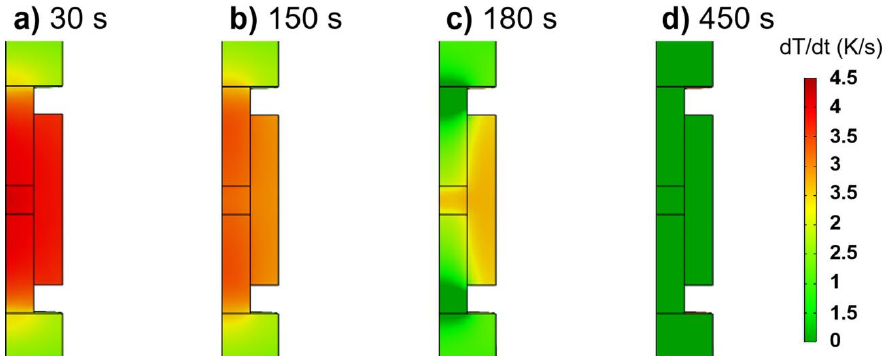
Figure 4. Typical heating rate fields from the punch-controlled PID regulation of regular temperature profile at different times: ( a ) 30 s; ( b ) 150 s; ( c ) 180 s; ( d ) 450 s.